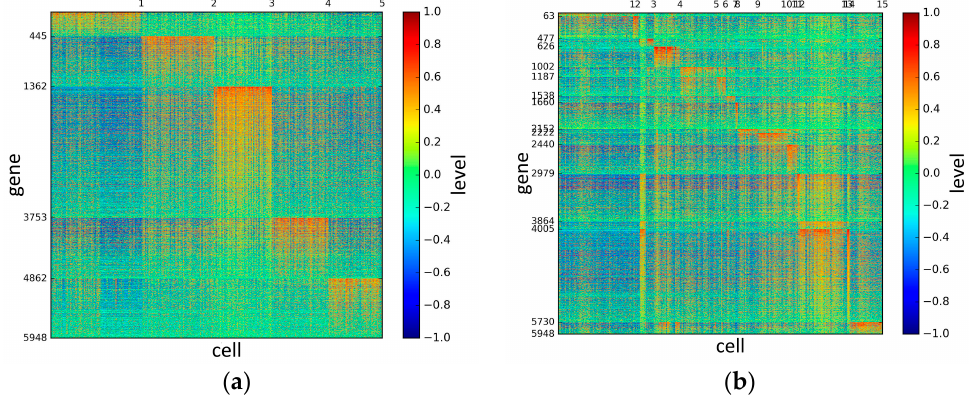
Figure 6. The heat maps of Treutlen datasets.